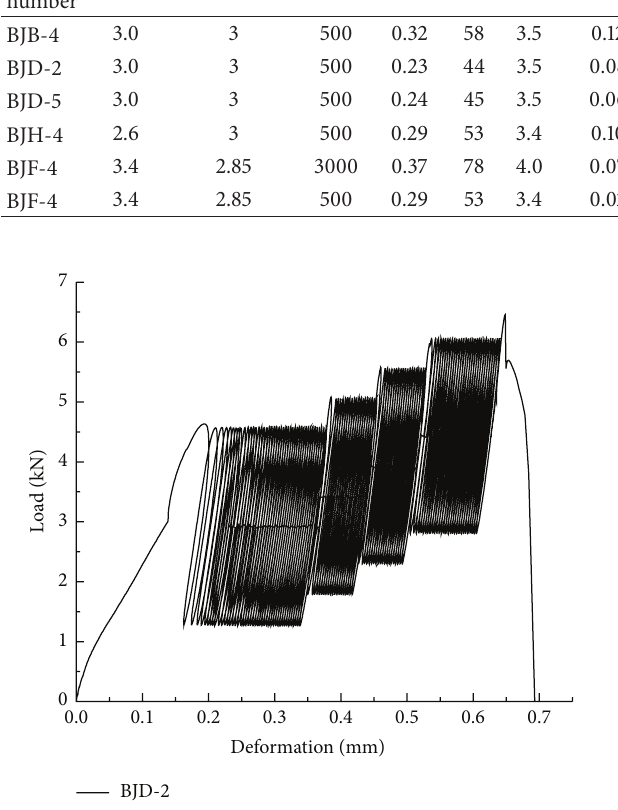
Figure 7: Load-deformation curves of Brazilian split fatigue tests of variational average